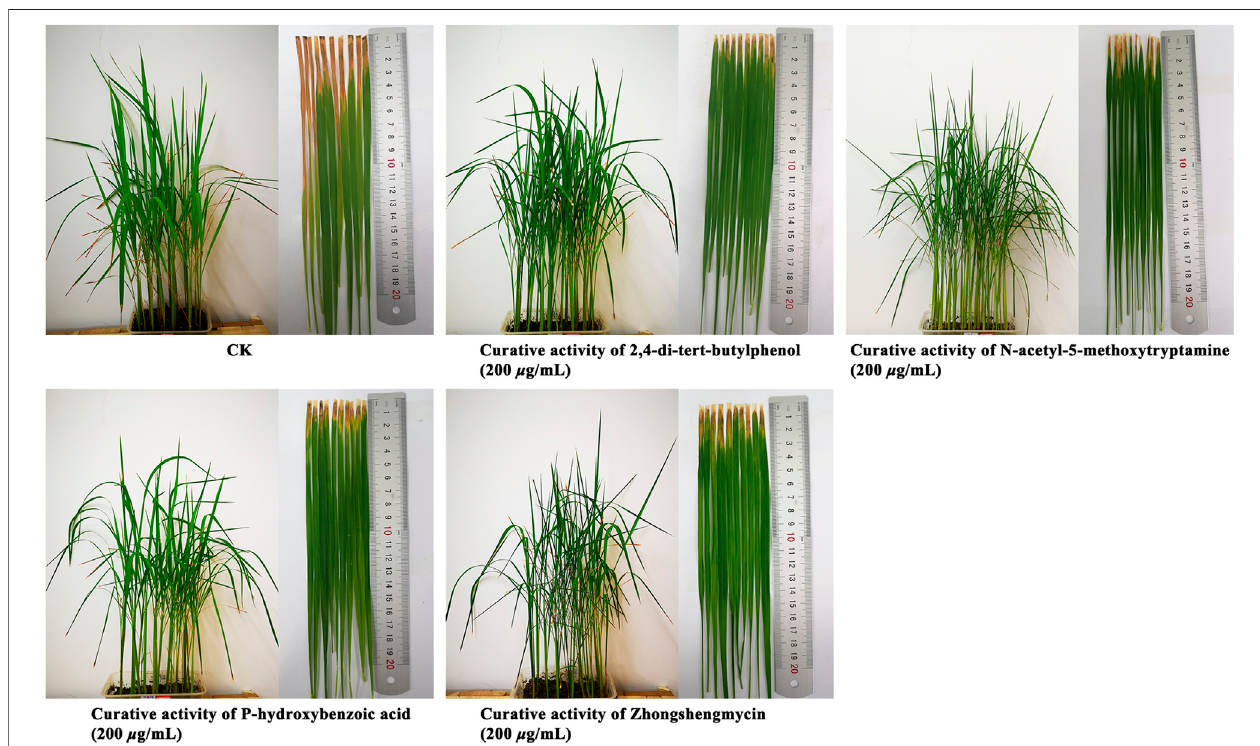
FIGURE 5 | Curative activity of 2,4-di-tert-butylphenol, N-acetyl-5-methoxytryptamine, P-hydroxybenzoic acid against BLB at concentrations of 200 μ g/ml.